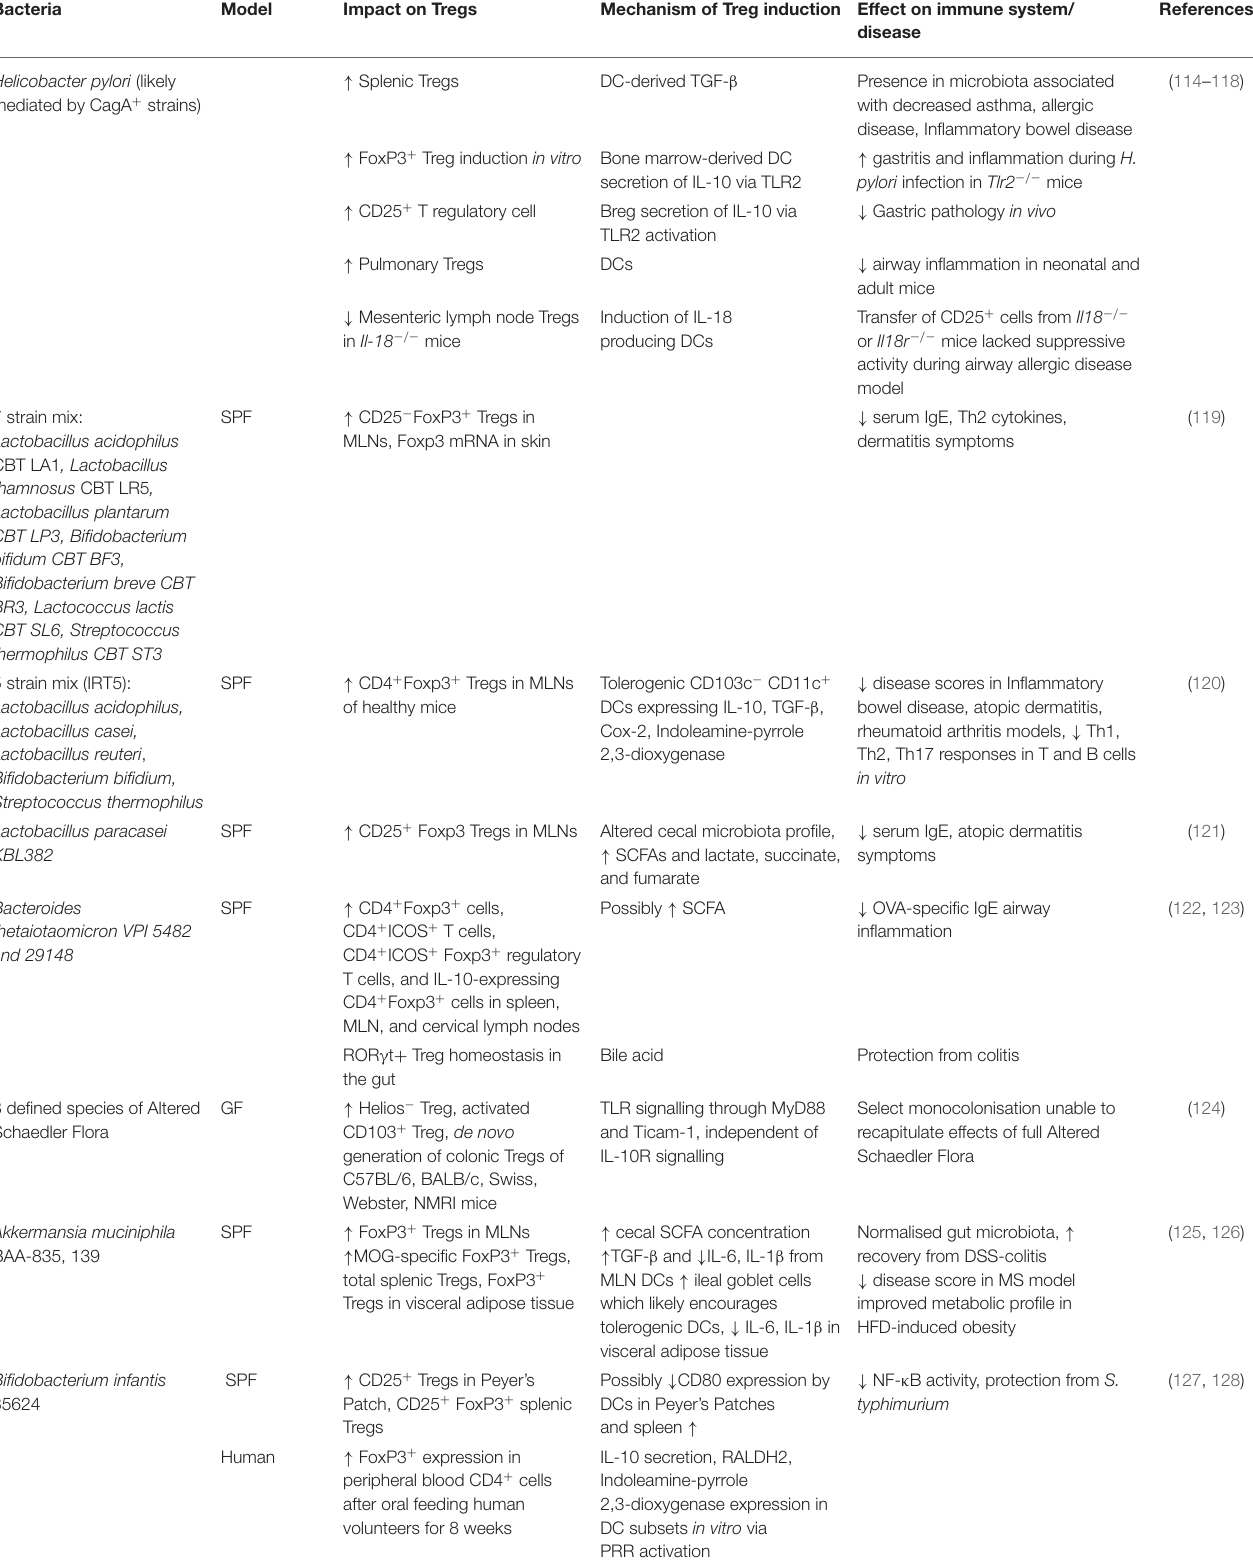
TABLE 2 | Impact of bacteria on Treg